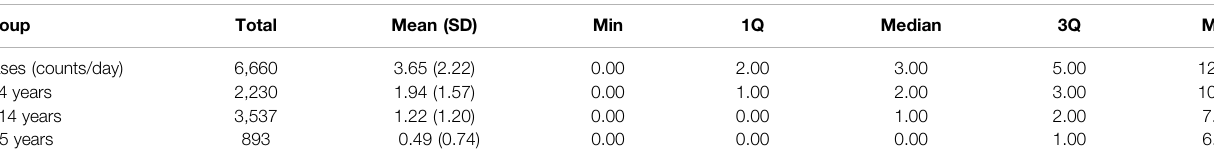
TABLE 2 | Descriptive analysis of mumps cases in Ningxia, 2015 – 2019.